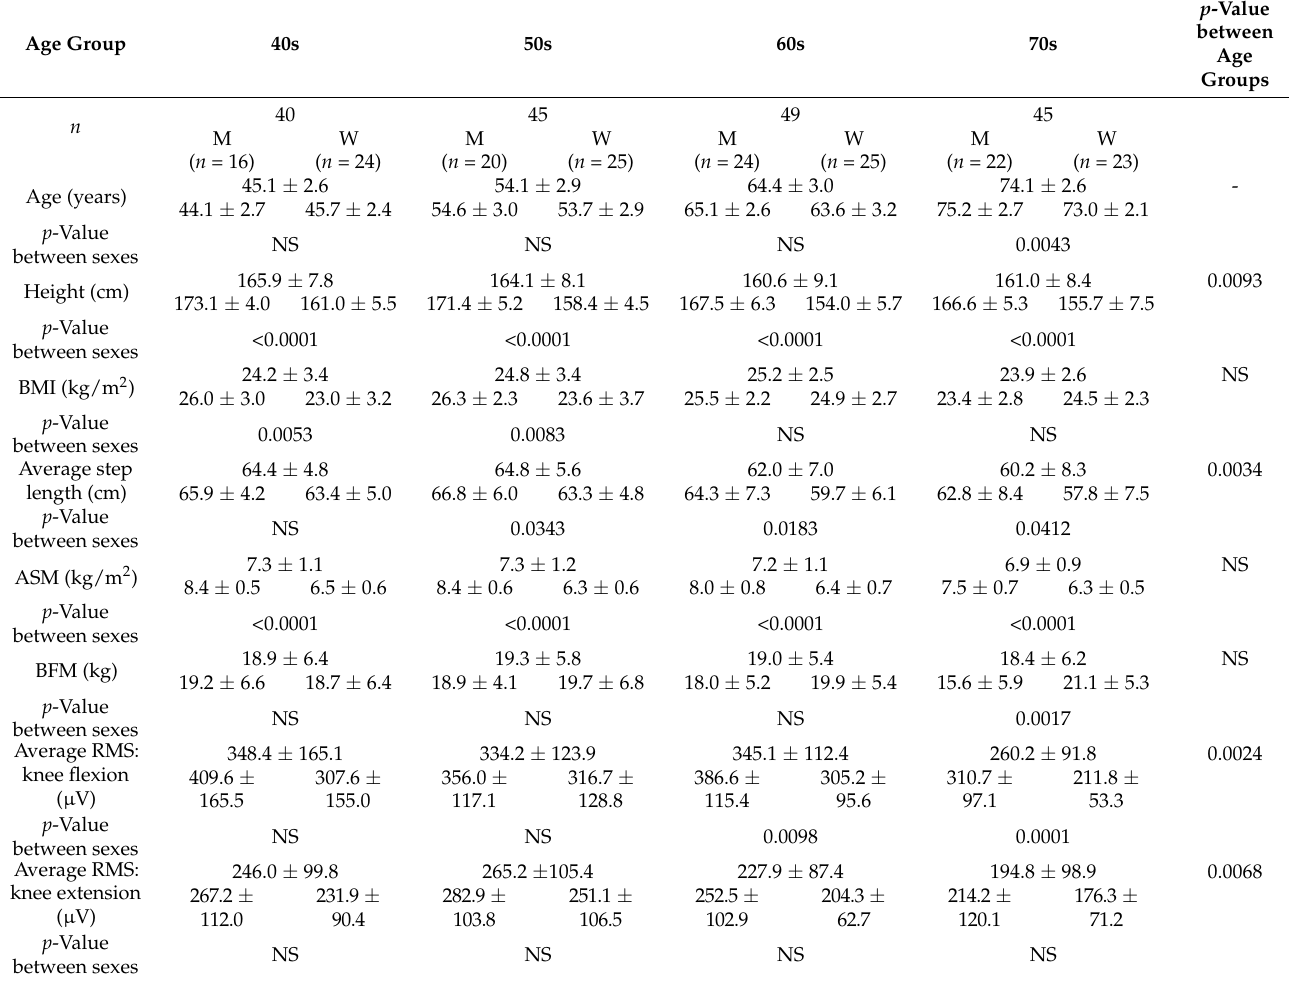
Table 2. Participant demographics and results of body impedance analysis and surface electromyog- raphy measurements by age group and